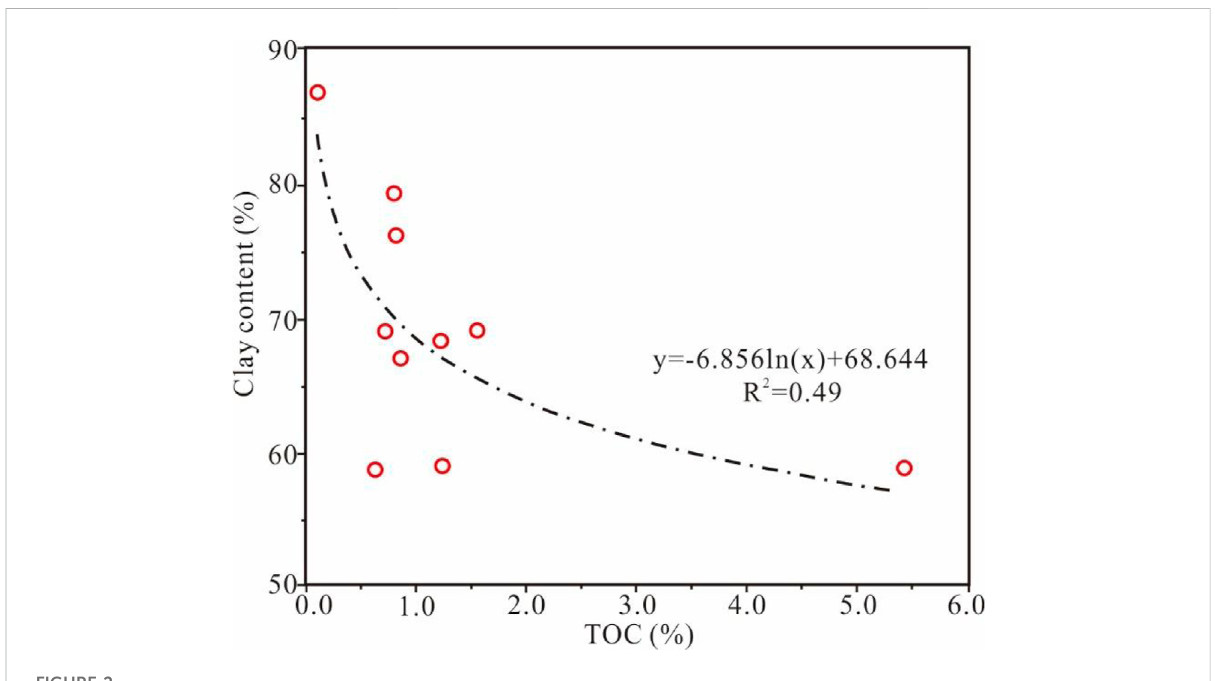
FIGURE 2 Relationship between shale TOC content and clay